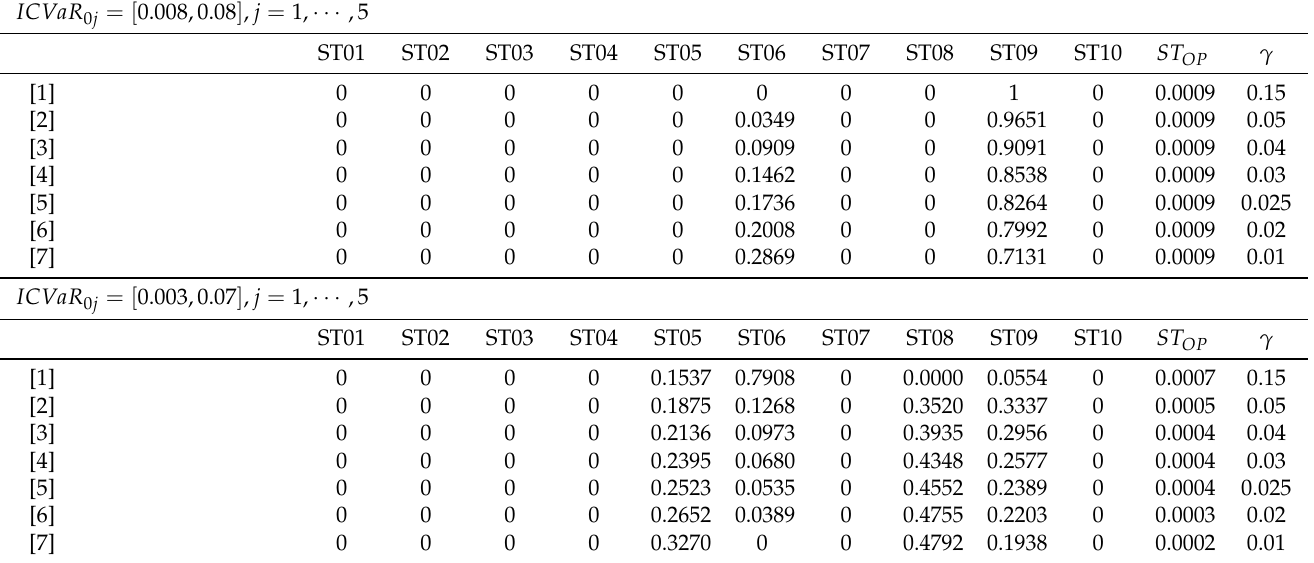
Table 3. Portfolio, Model 1 with the same ICVaR 0 j , j = 1, · · · ,5.